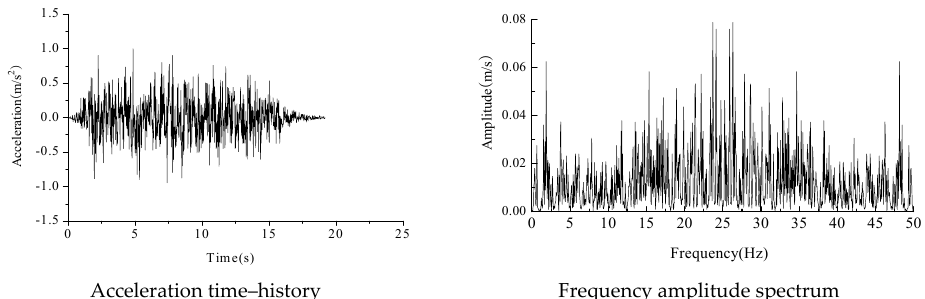
Figure 13. Lanzhou motion in the horizontal direction after inversion.